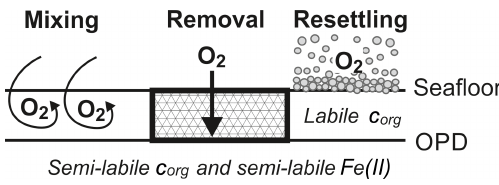
Figure 9. Schematic characterization of the different impact types at a mined seafloor and their influence on O 2